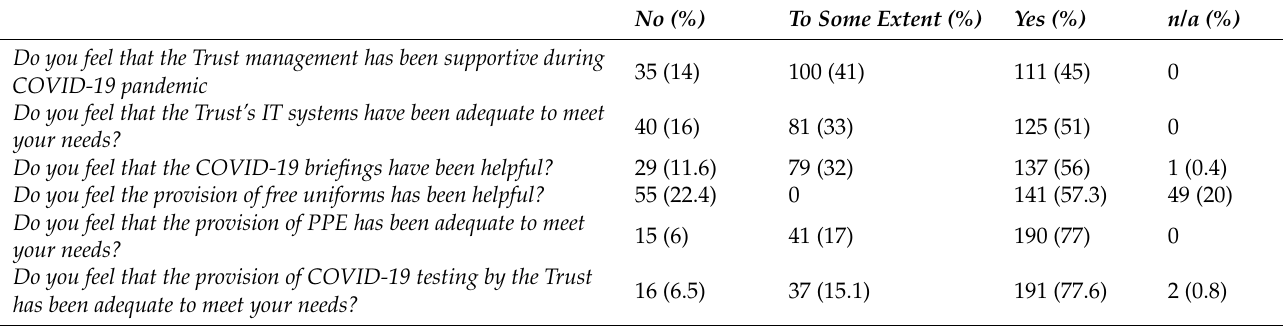
Table 3. Forensic staff perception of support by TEWV during the COVID-19 pandemic. No (%) To Some Extent (%) Yes (%) n/a